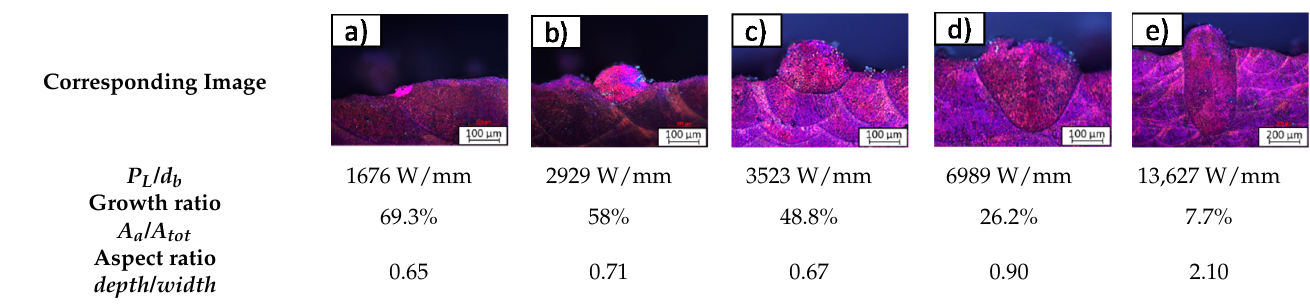
Figure 7. Exemplary images of melt beads with pores. ( a ) Melt bead generated with 𝑃 (cid:3013) /𝑑 (cid:3029) = 2631 W/mm with irregular pores. ( b ) Detail of Figure 7 ( a ) with irregular pores highlighted with yellow arrows. ( c ) Melt beads generated with 𝑃 (cid:3013) /𝑑 (cid:3029) = 7884.2 W/mm with one great spherical pore inside the melt bead (left). Same parameter set on the melt bead on the right side with the formation of small spherical pores only. ( d ) Detail of Figure 7 ( c ) (left) with one great spherical pore highlighted with green arrow. ( e ) Detail of Figure 7 ( c ) (right) with small spherical pores highlighted with black arrows. Table 2. Influence of 𝑃 (cid:3013) /𝑑 (cid:3029) on the resulting growth ratios and aspect ratios. Parameters: 𝑑 (cid:3029) = 100 µm, 𝑣 = 1.3 m/s.